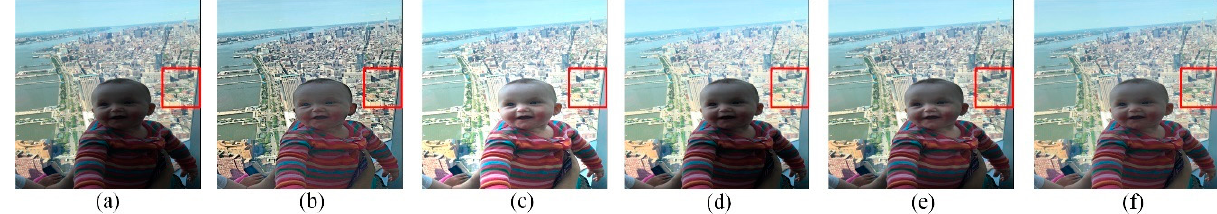
Figure 18. Urban image. ( a ) Original image; ( b ) result of Lee’s method; ( c ) result of LIME; ( d ) result of AGCWD; ( e ) result of SIRE; (f) result of the proposed method.